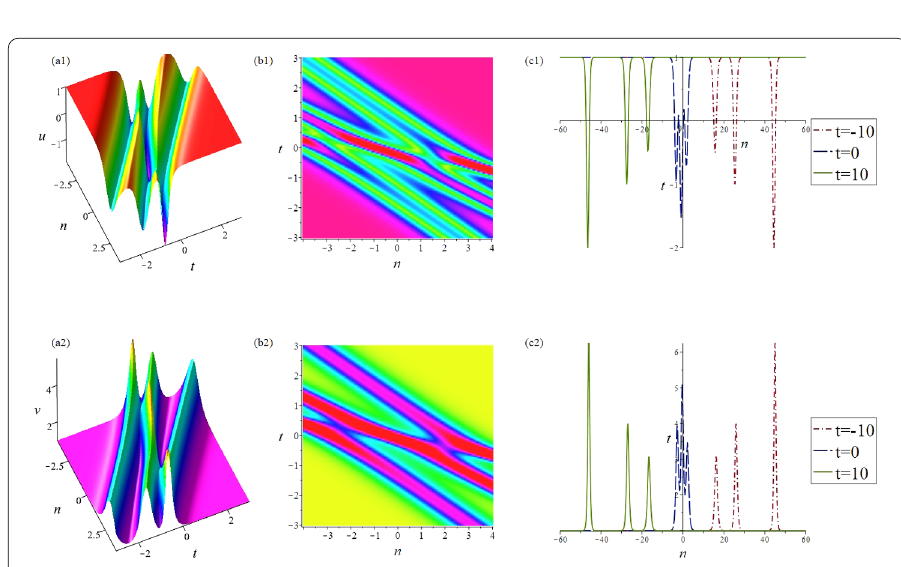
Figure 4 ( a1 )–( c1 ) Overtaking elastic interactions of dark three-soliton solution (cid:8) u n in (45). ( a2 )–( c2 ) Overtaking elastic interactions of bright four-soliton solution (cid:8) v n in (45) with the same parameters as in (a1)–(c1). The same parameters as Fig. 3 except that λ 4 = –1